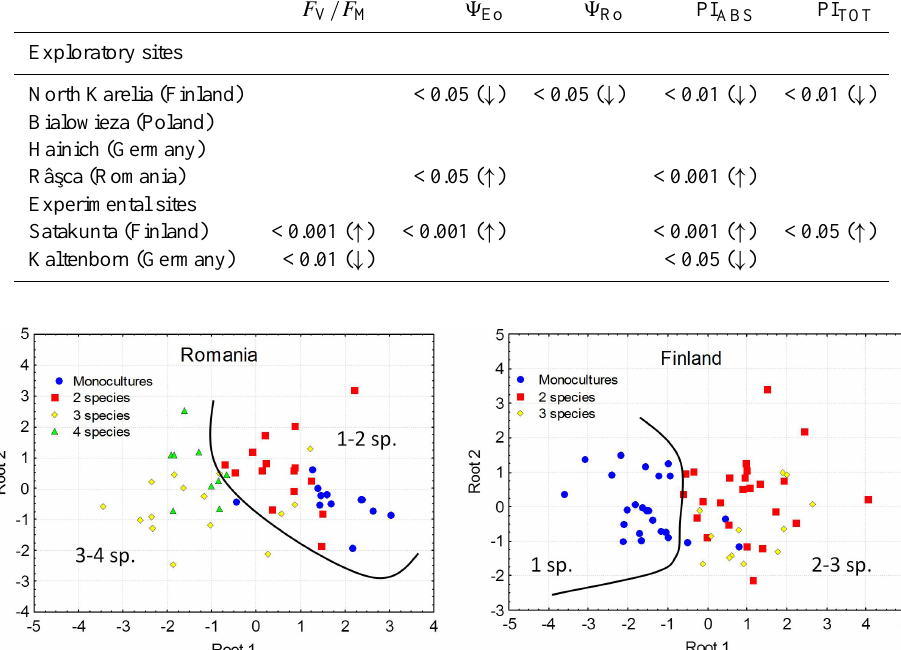
Figure 1. Discriminant analysis applied on the exploratory sites of Romania and Finland. Homogeneous groups are defined in based on the species richness. We observe that few species plots are roughly distinct from the majority of species